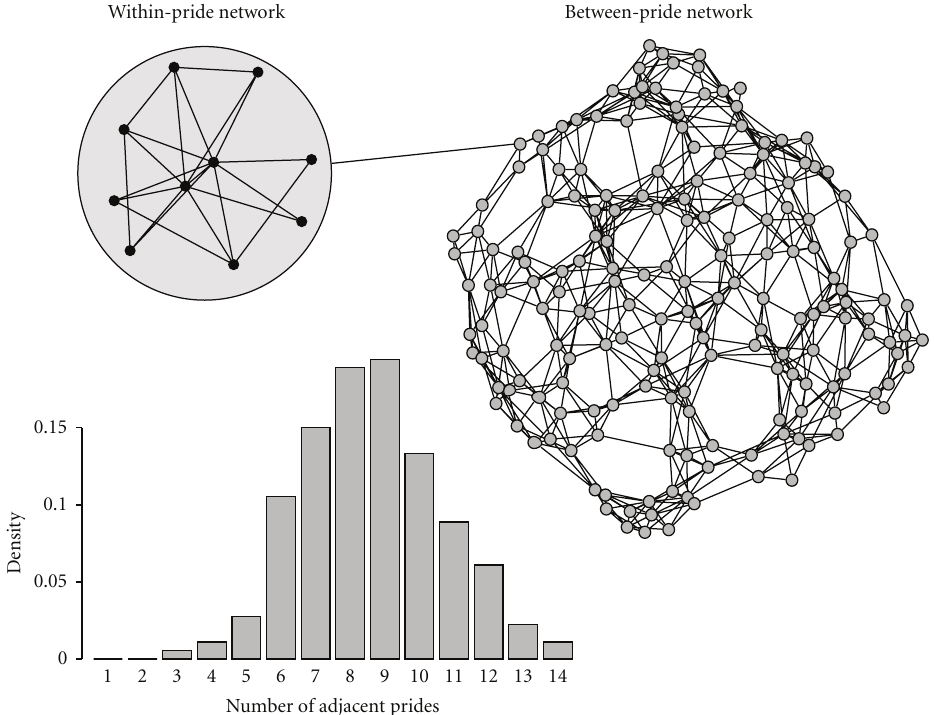
Figure 1: An example of a wildlife network: the Serengeti lion network [4]. In the within-pride network, the nodes (circles) are individuals and edges (lines between circles) are contacts observed on a short time scale (this is a cartoon, not based on data). The between-pride network is derived from behavioral observations of individually known lions as in [4] where nodes represent prides, and edges represent contacts between prides. The histogram represents the degree distribution of the between-pride